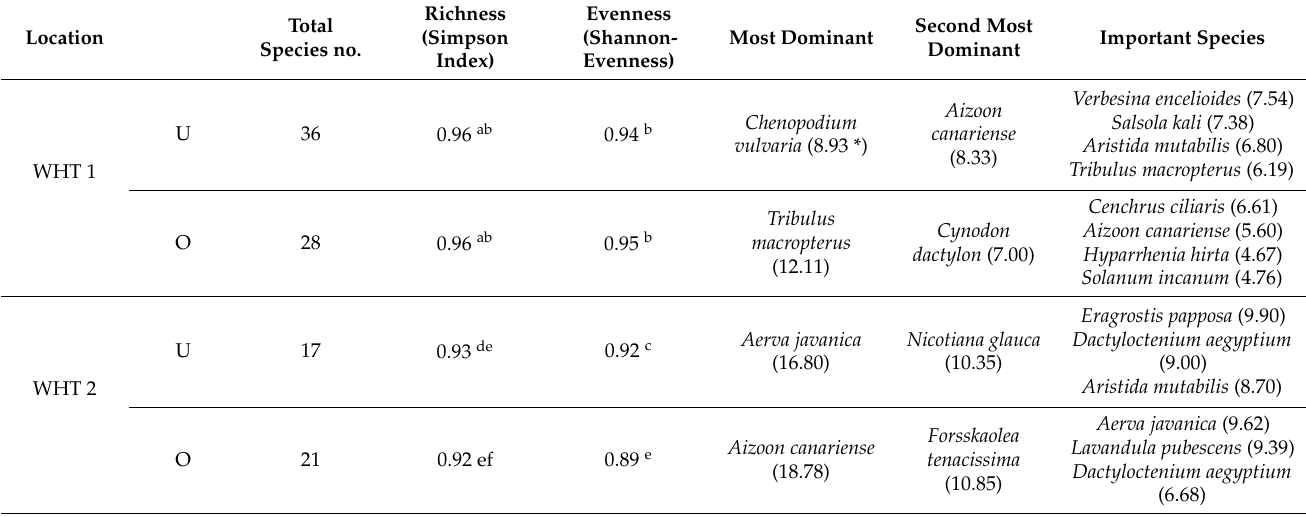
Table 1. Plant species richness, evenness, and dominance of the studied locations invaded by Nicotiana glauca in the Taif region, western Saudi